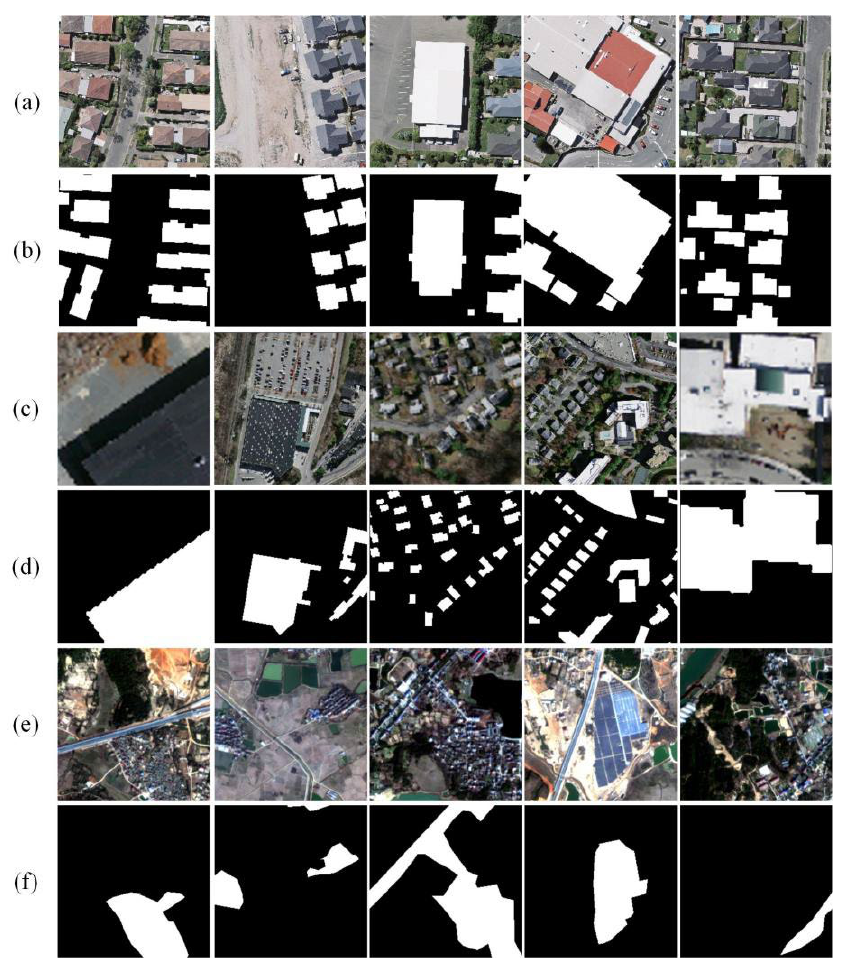
Figure 5. Different buildings in the three datasets: ( a , b ) are WBD building images and corresponding labels, ( c , d ) are MBD building images and corresponding labels, and ( e , f ) are GID building images and corresponding labels, respectively. Table 1. Amounts of labeled